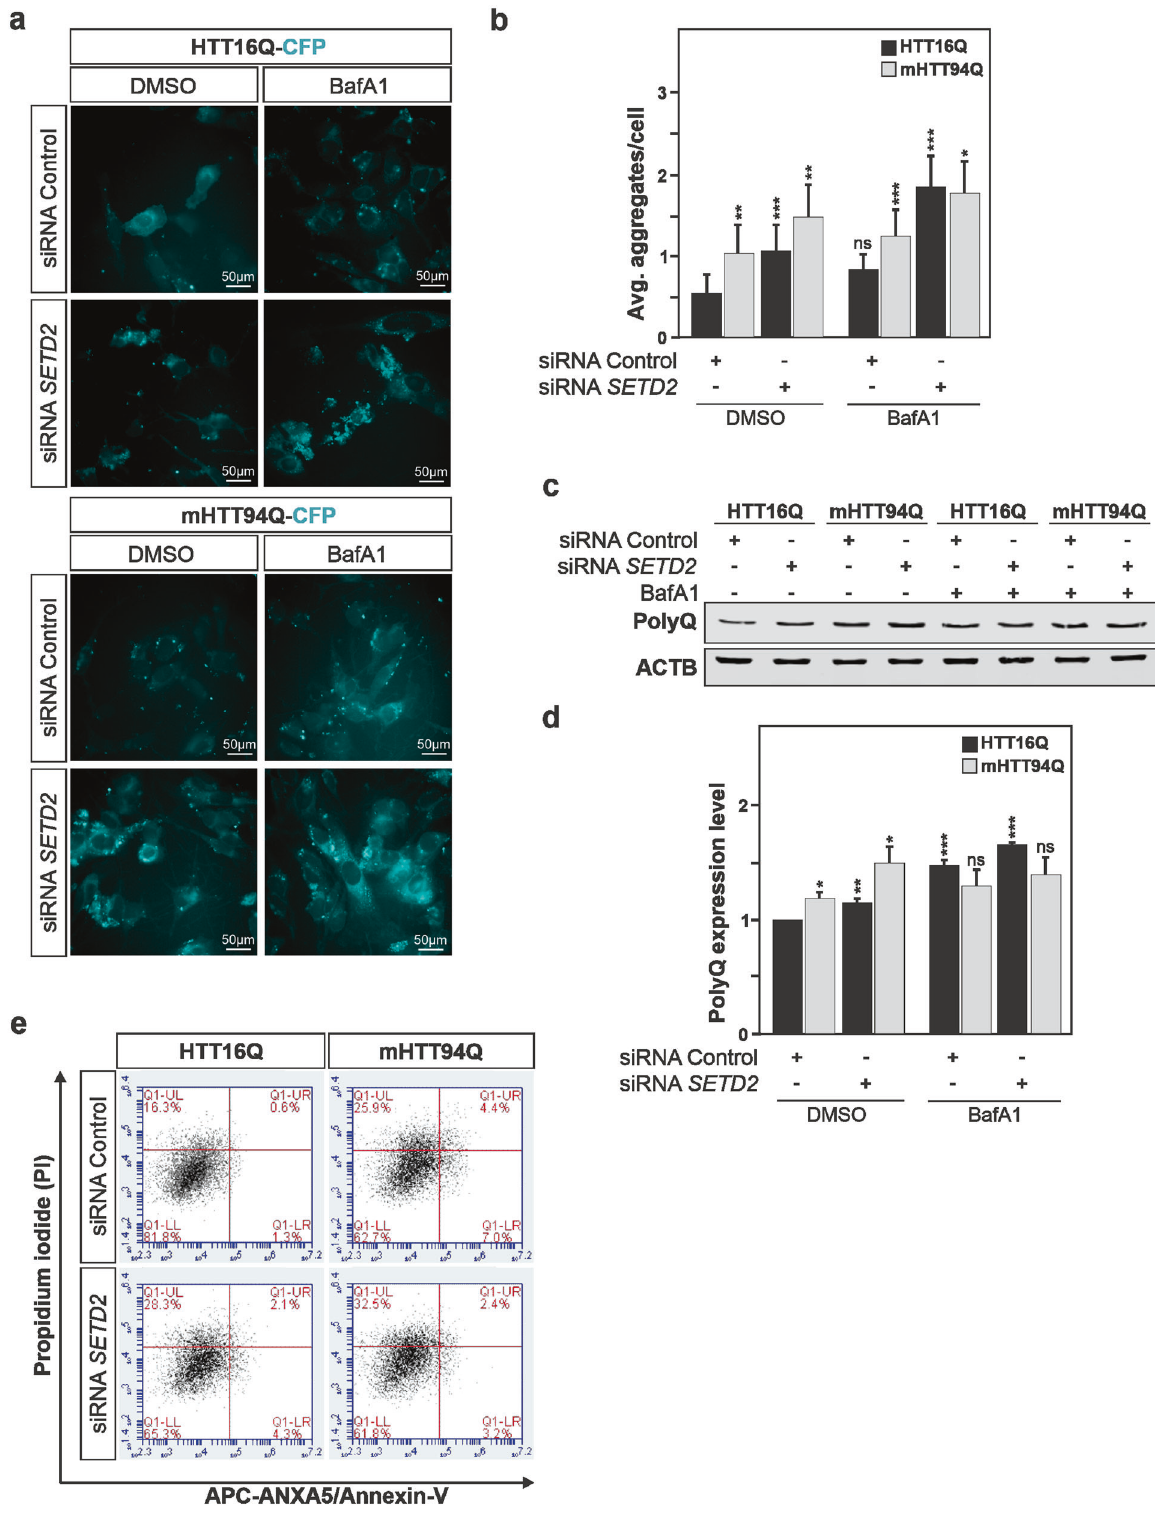
Fig. 7 SETD2 de fi ciency is associated with decreased turnover of mutant HTT protein and increased cellular toxicity. a , b HeLa cells were transfected with a control non-targeting siRNAs pool or SETD2 siRNAs pool for 48 h and thereafter transfected with the wild-type HTT16Q-CFP or disease-associated mutant mHTT94Q-CFP expression vectors for 24 h prior to protein aggregates assessment. Quanti fi cation of aggregates per cell is depicted in panel b . c Immunoblot analysis of HTT16Q and mHTT94Q expression levels in cells, under identical conditions as described above, using an antibody targeting polyQ. d Cell death analysis of HeLa cells transfected with wild-type HTT16Q or disease- associated mutant mHTT94Q plasmid with or without siRNA SETD2 (a non-targeting siRNAs pool was used as a control). Propidium iodide is shown on the Y axis and ANXA5/annexin-V-APC on the X axis. Bars display the mean of at least three independent experiments ( a – d , n = 3; e , n = 5), error bars represent SEM; * P < 0.05, ** P < 0.01, *** P < 0.001. Cell Death and Disease (2022)